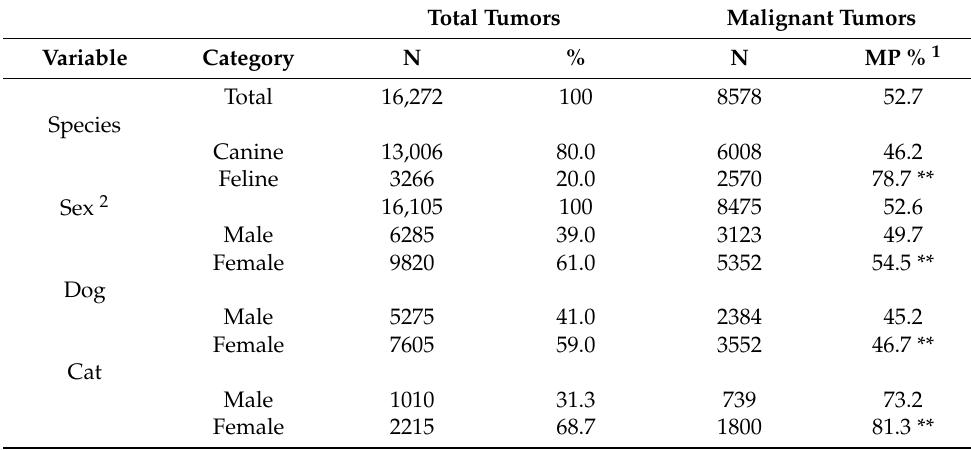
Table 2. Description of the biologic behavior of tumors by species and sex.